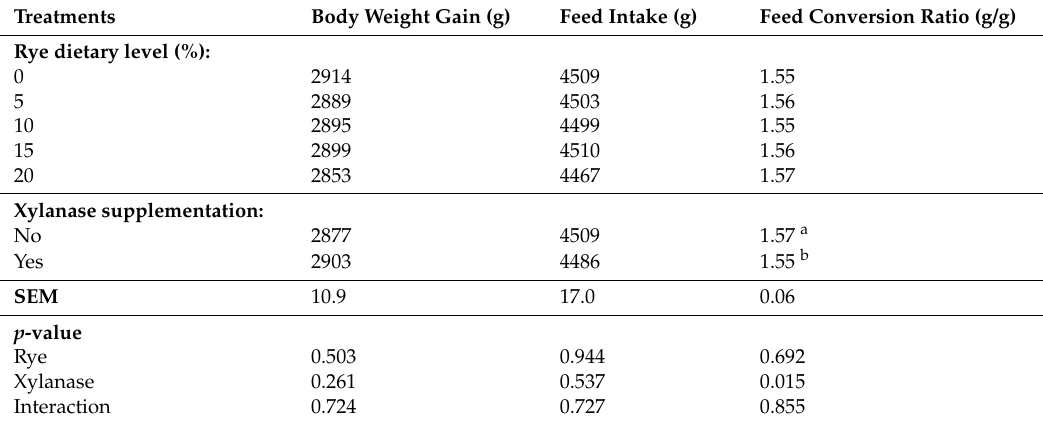
Table 5. Effects of dietary treatments on broiler performance in entire period of feeding 1 , 1–42 d of age.